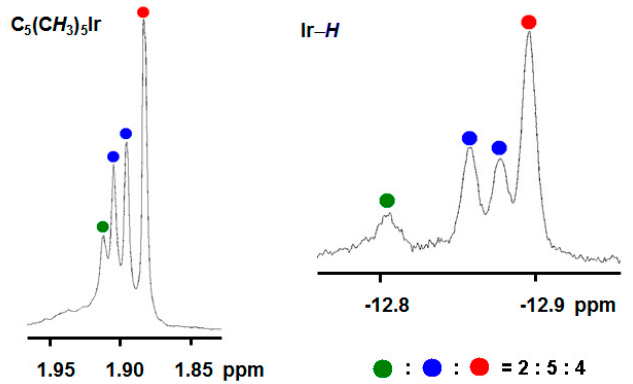
Figure 2. Selected 1 H NMR spectrum of a streoisomeric mixture of hydridoiridium generated from 6 with 2-propanol.